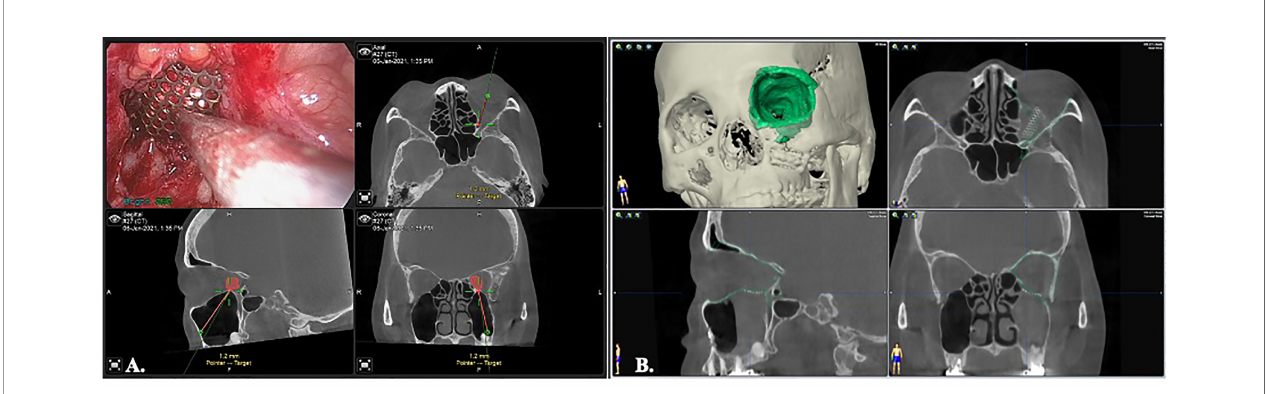
FIGURE 5 | Image-controlled orbital fl oor reconstruction. (A) position control of the Ti-mesh by real time navigation. (B) post-op image showed high level of accuracy with orbital fl oor reconstruction. Green: pre-operative